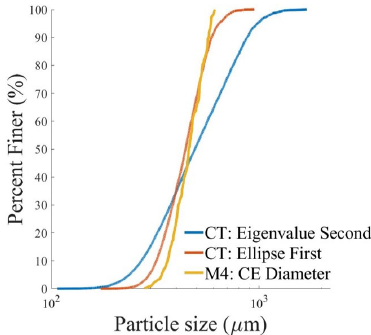
Figure 1. Morphologi 4 ID compared to XRCT. "Eigenvalue Second" assumes particle diameter of second largest axis length using "Eigenvalues" method. "Ellipse first" assumes particle di- ameter of largest axis using "Principal Axis Length"